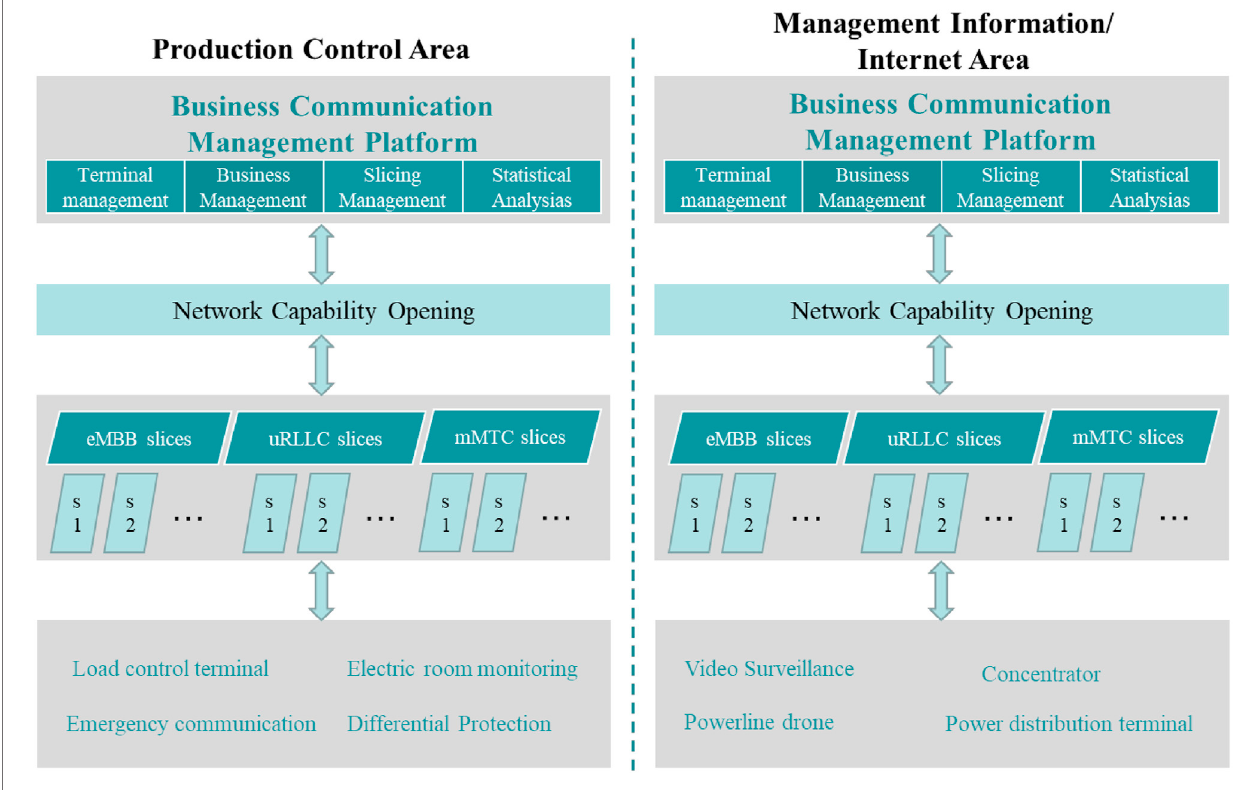
FIGURE 2 | Power 5G service deployment